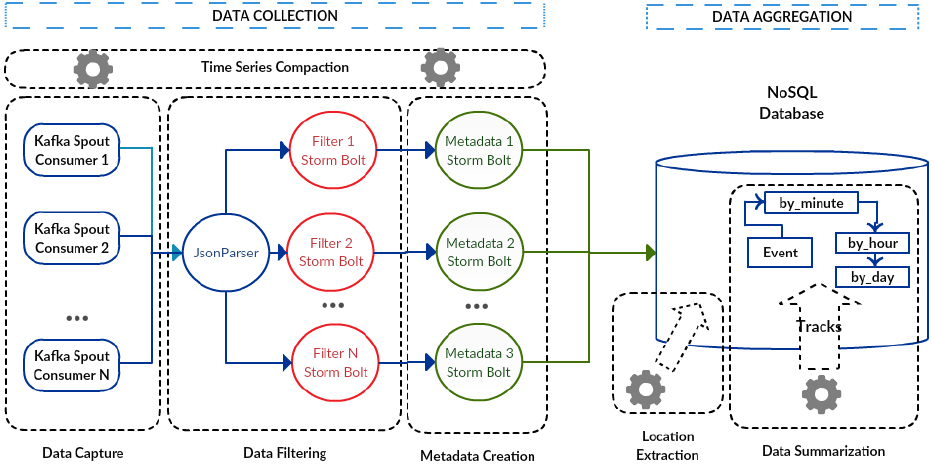
Figure 7. DDS Figure 7. DDS topology.